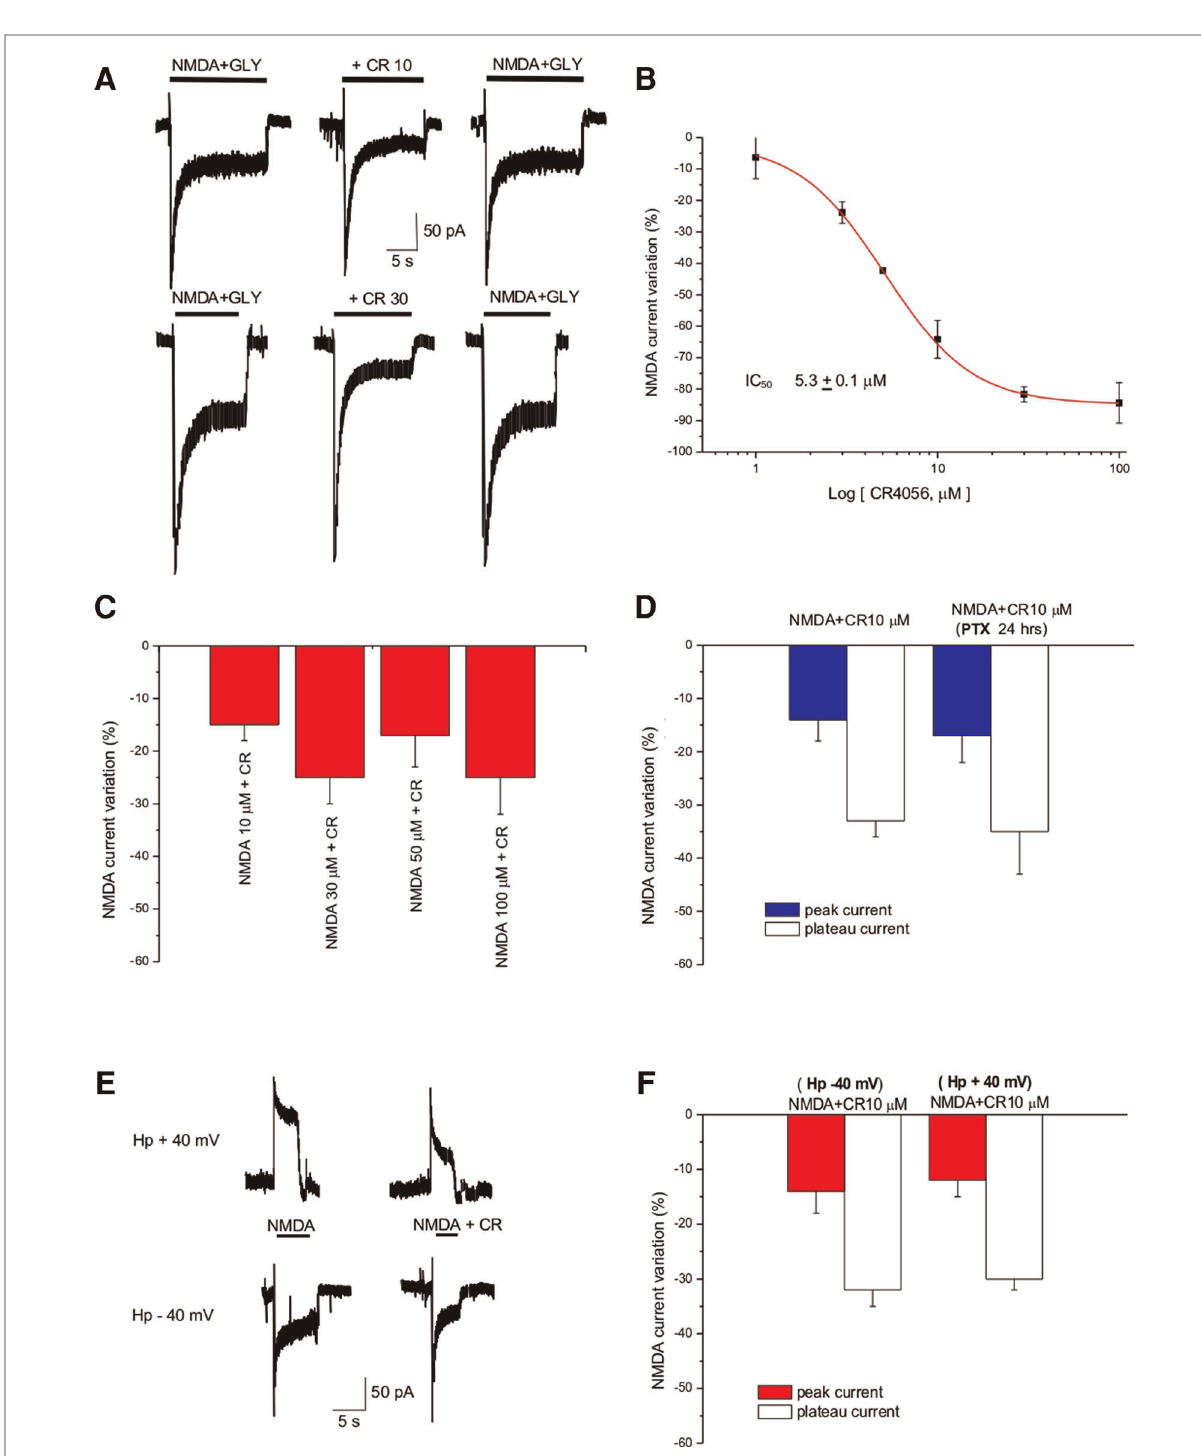
FIGURE 1 CR4056 decreases NMDA-evoked current in cortical cultures. ( A ) Representative traces showing the effect of CR4056 (10 µM and 30 µM) on the current evoked by NMDA (100 µM)+Glycine (Gly, 10 µM) application. ( B ) Dose response curve of the effect of CR4056 on NMDA plateau current. Each point is the mean±SE of 5 – 7 experiments. ( C ) Histogram summarizing the effect of CR4056 (10 µM) on the current elicited by increasing concentrations of NMDA. ( D ) Effect of CR4056 on NMDA- peak and plateau current in control and after 24 h incubation with PTX (200 ng/ml, preincubated for 24 h) ( E ) Representative traces showing NMDA-evoked current before and after CR4056 (10 µM) application in a neuron held at − 40 mV (lower trace) and at +40 mV (upper trace). ( F ) Histogram displaying the reduction of NMDA peak and plateau current after CR4056 application at − 40 or +40 mV. Each histogram bar is the mean±SE of 6 cells. In the experiments of panels ( C – E ) no signi fi cant differences were detected between groups ( p